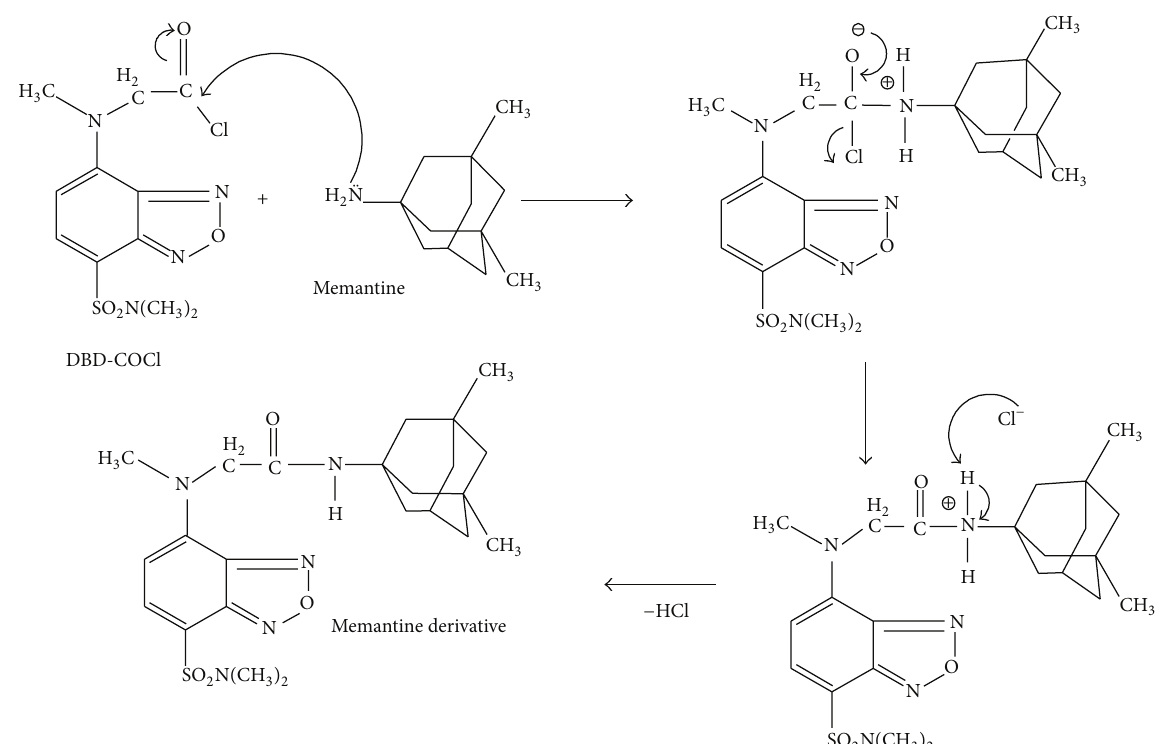
Figure 2: Proposed mechanisms for the memantine fluorescent derivative formation.